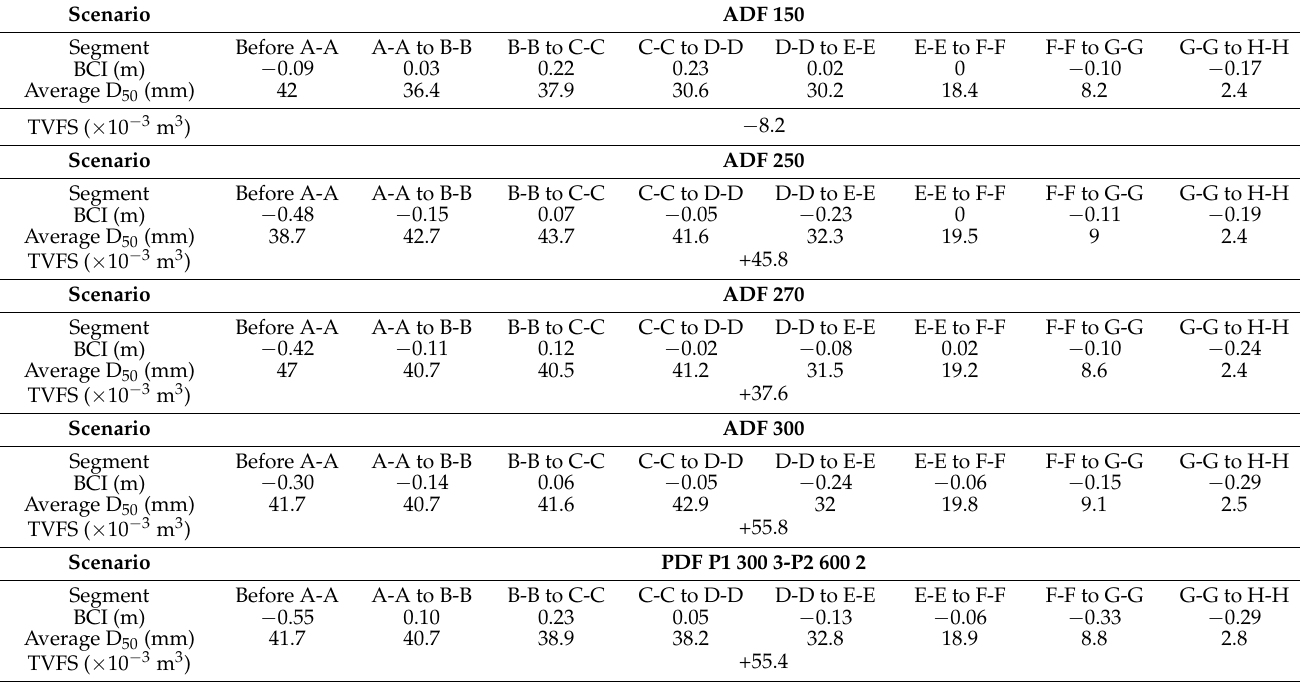
Table 3. Average bed-level changes assessed by the BCI parameter compared with the reference case (i.e., calibrated model for the 2012 flushing operation) and median sediment-size variation in the target subareas in the Unazuki Reservoir under different ADF scenarios and a selected PDF scenario. Negative and positive signs of TVFS indicate deposition and erosion,